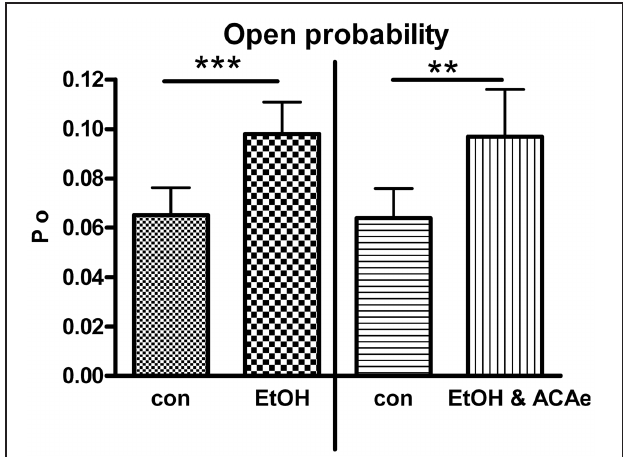
FIGURE 1 | Combined extracellular EtOH/ACA application. Effect of 30mM EtOH in absence (left panel, Paired Student’s t -test: ∗∗∗ p < 0 . 001, n = 23) and in presence of ACA at the extracellular side (ACAe, right panel, Paired Student’s t -test: ∗∗ p < 0 . 01, n = 16). In both cases open probability ( Po ) was significantly increased compared to control